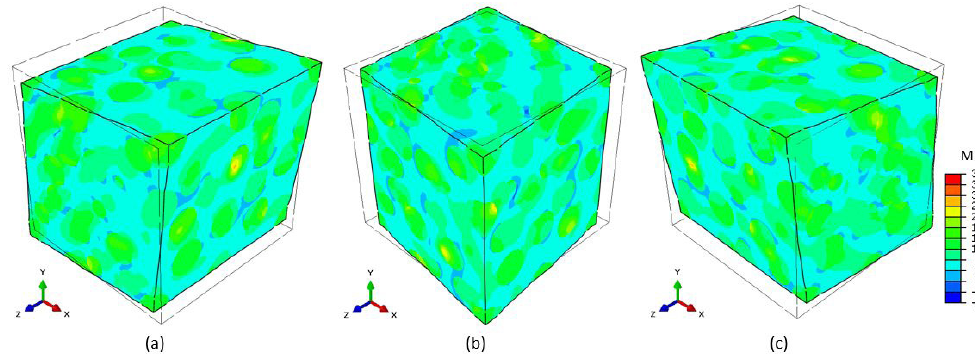
Figure 13. Principal stress fields on RVE under different shearing loading states in the deformed configuration.